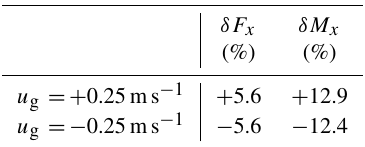
Table 1. Gust-induced peak loads on the rotor during the 1 − cos() gust in relation to the constant blade load.